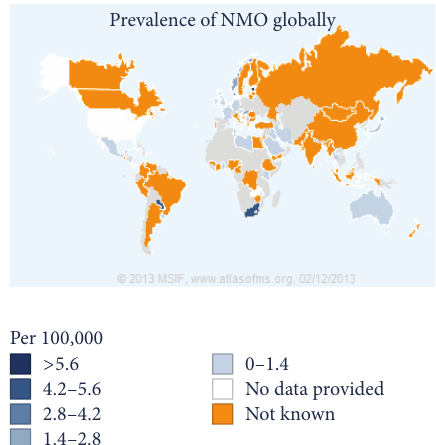
Figure 2: Prevalence of Neuromyelitis optica globally. (Data gath- ered from query data of Multiple Sclerosis International Federation